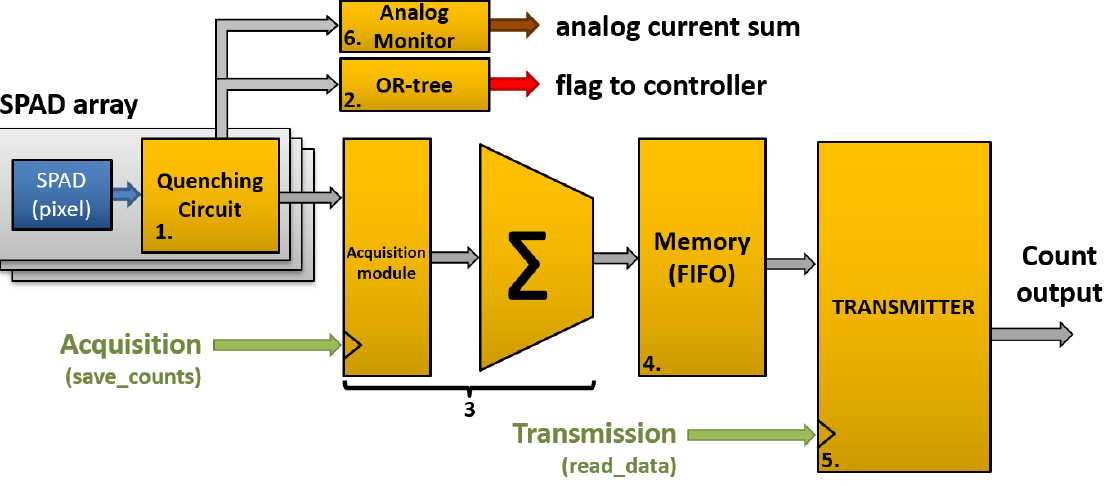
Figure 14. Block diagram of a 3D PDC dedicated to LAr and LXe. (1) The SPAD and QC; (2) A flag is set as soon as a photon is detected on any SPAD; (3) The acquisition module saves the actual count of triggered SPADs; (4) The FIFO saves the number of counts as a function of time; (5) The transmitter sends the counter’s value to the acquisition system; (6) The analog current sum is proportional to the number of detected photons, as shown in Figure